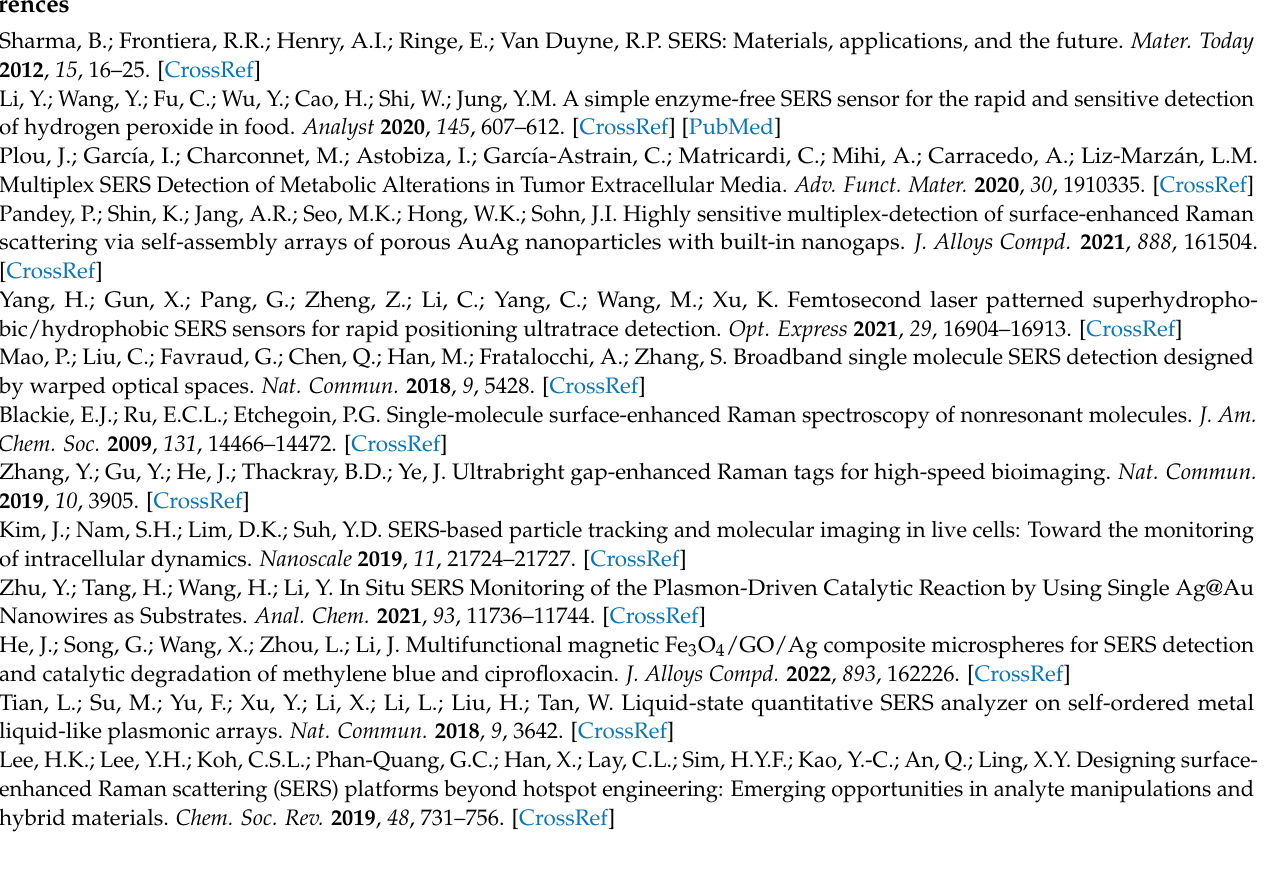
SERS reproducibility; Table S1: Raman band assignments of R6G molecules; Table S2: Comparison of SERS performance of current work and previously reported plasmonic NP-based SERS substrates (references [45–53] are cited in Table